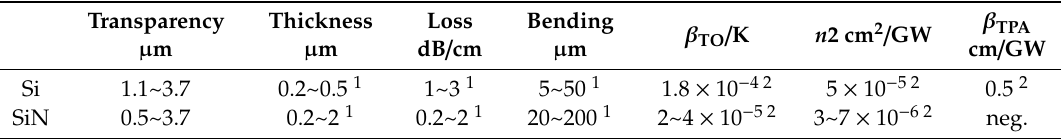
Table 3. A comparison of typical designs and properties between Si and SiN waveguide with SiO 2 claddings.